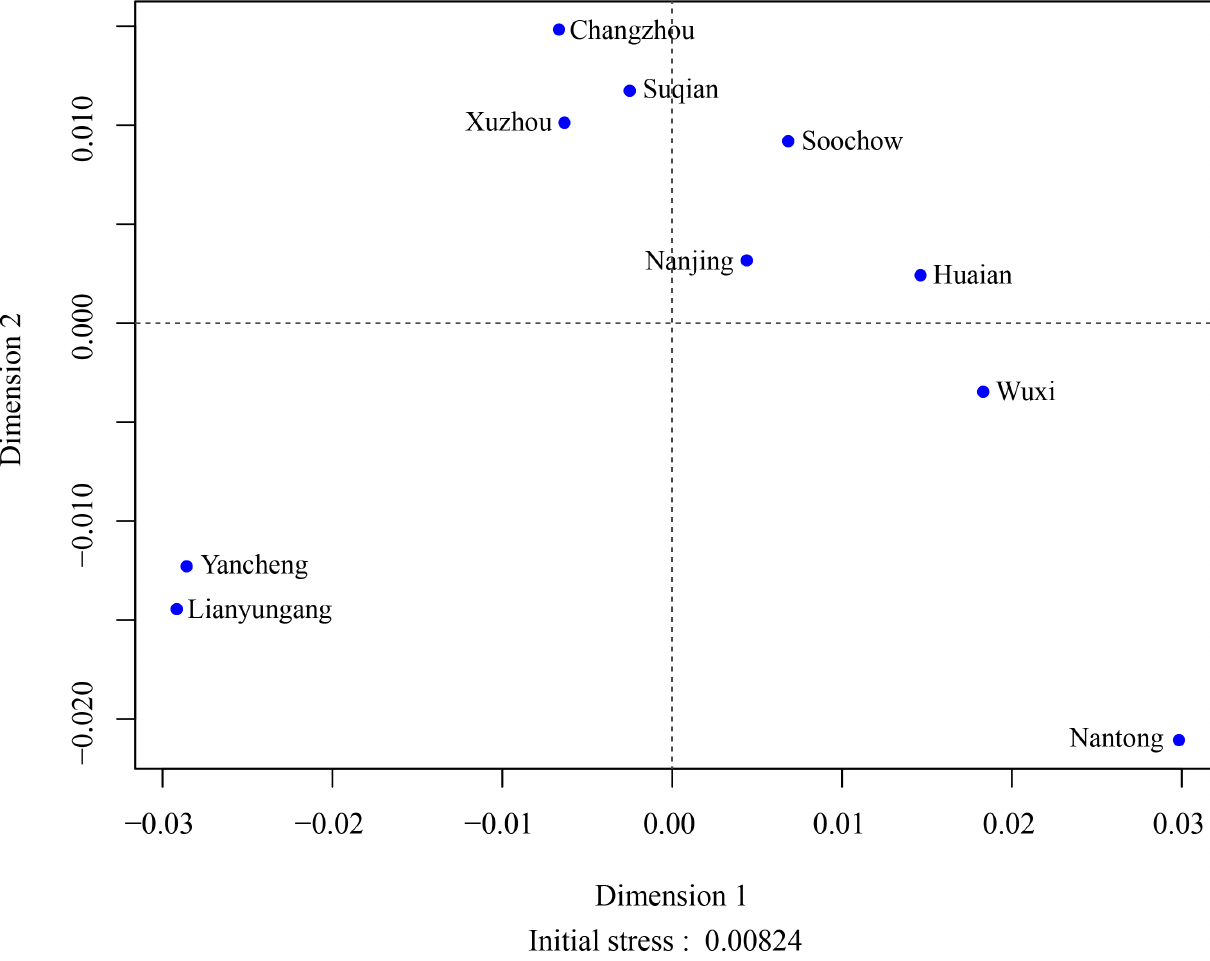
Fig 4. A Multi-Dimensional Scaling (MDS) plot constructed according to the R ST genetic distance matrix among 10 Han populations in Jiangsu province. The initial stress was 0.00824.